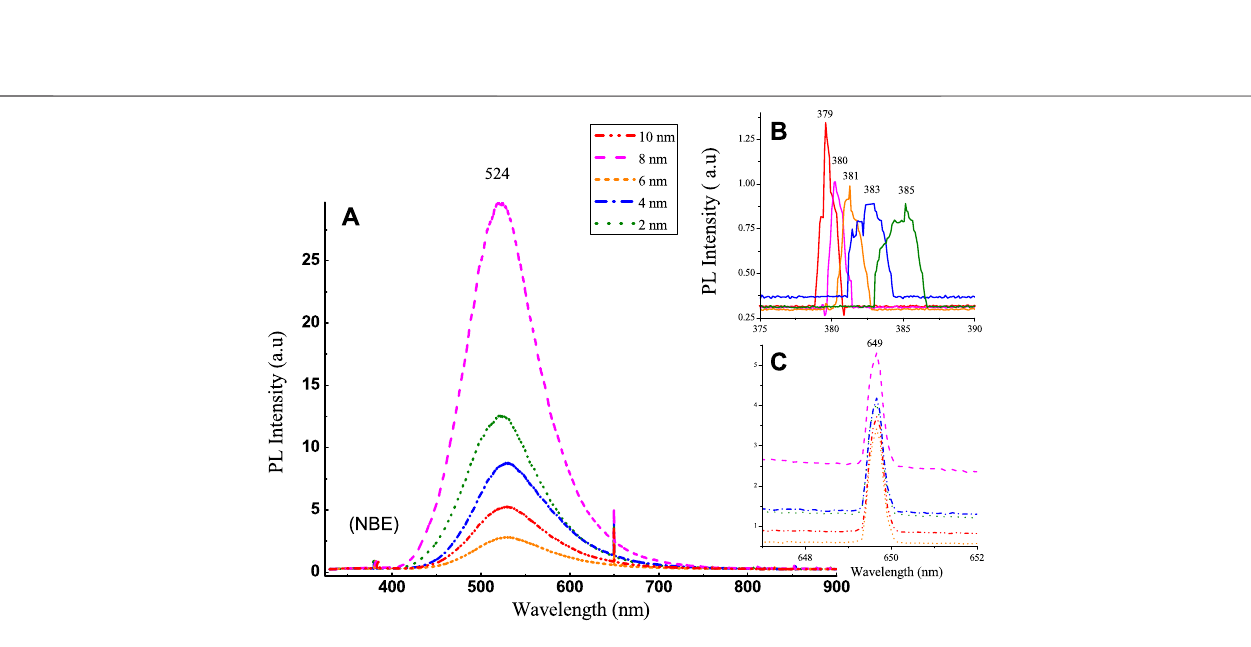
Frontiers in Materials |